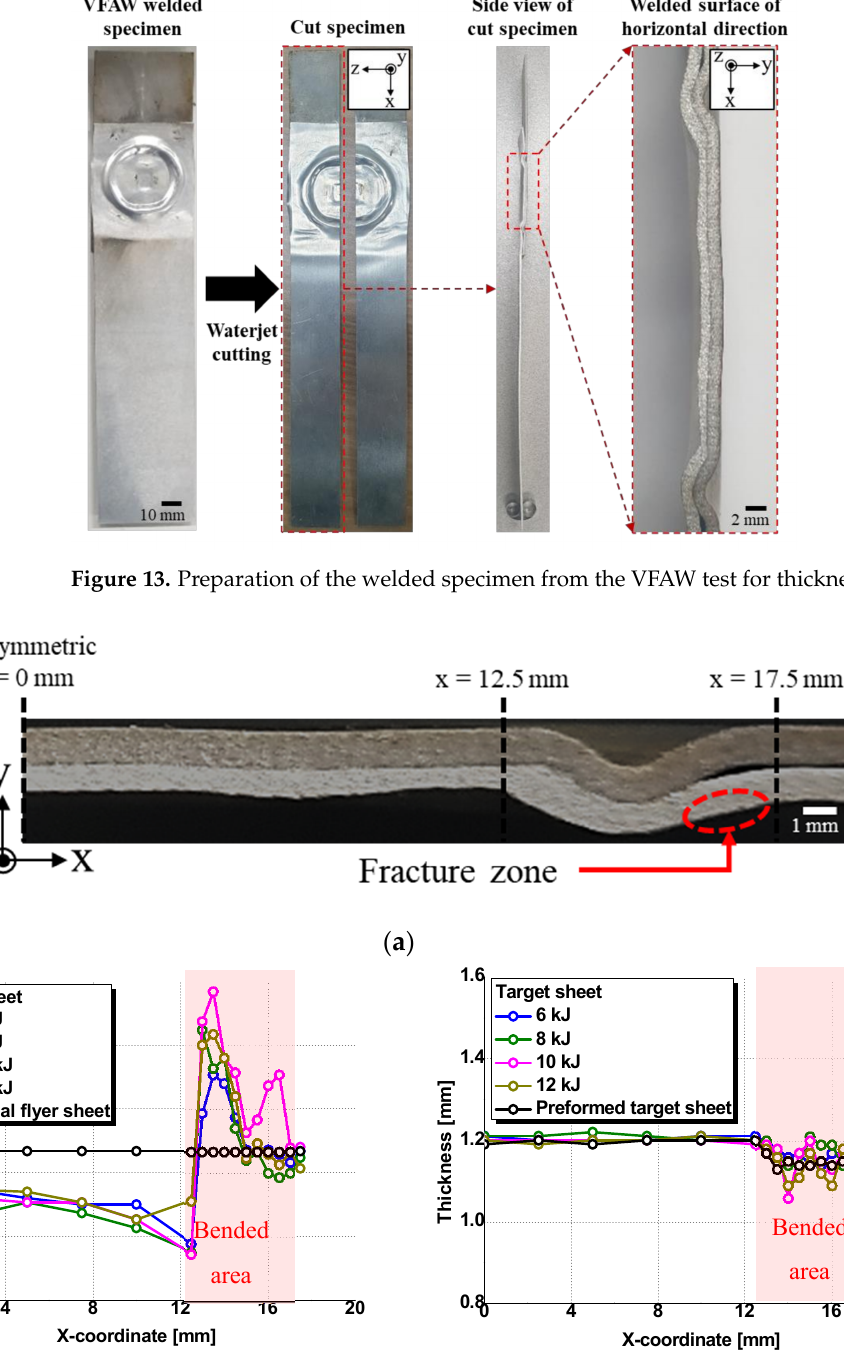
Figure 12. Load–displacement curve in a lap shear test with respect to the input energy.